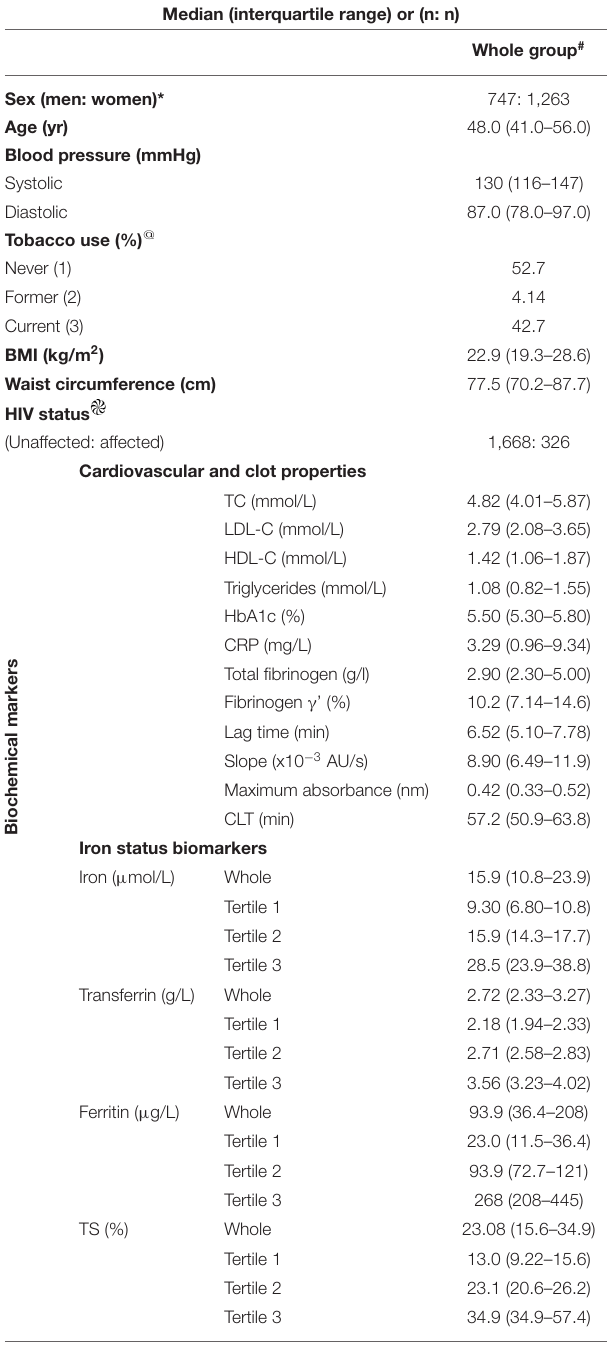
TABLE 1 | Specific characteristics of participants. Median (interquartile range) or (n: